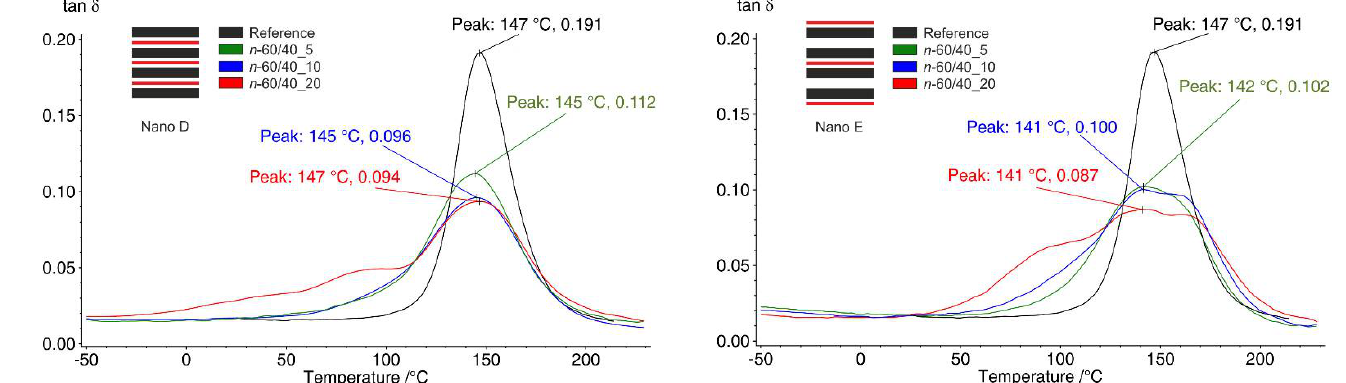
Figure 6. Comparison of tan δ curves of Nano E ( left ) and Nano D ( right ) laminate configurations.